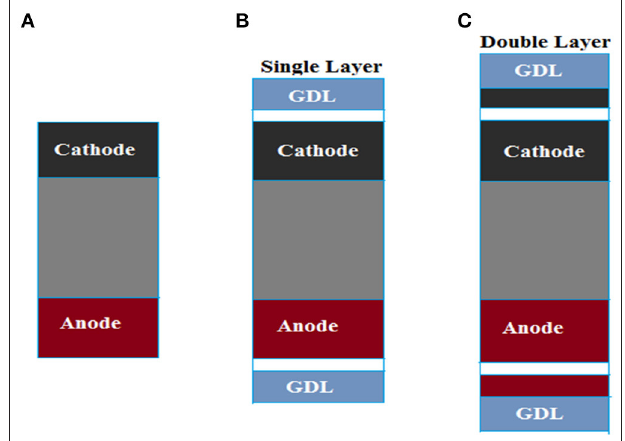
FIGURE 1 | Design of three membrane electrode assemblies (MEAs): (A) MEA 1, without GDL; (B) MEA 2, with single-layer electrodes; (C) MEA 3, with double-layer